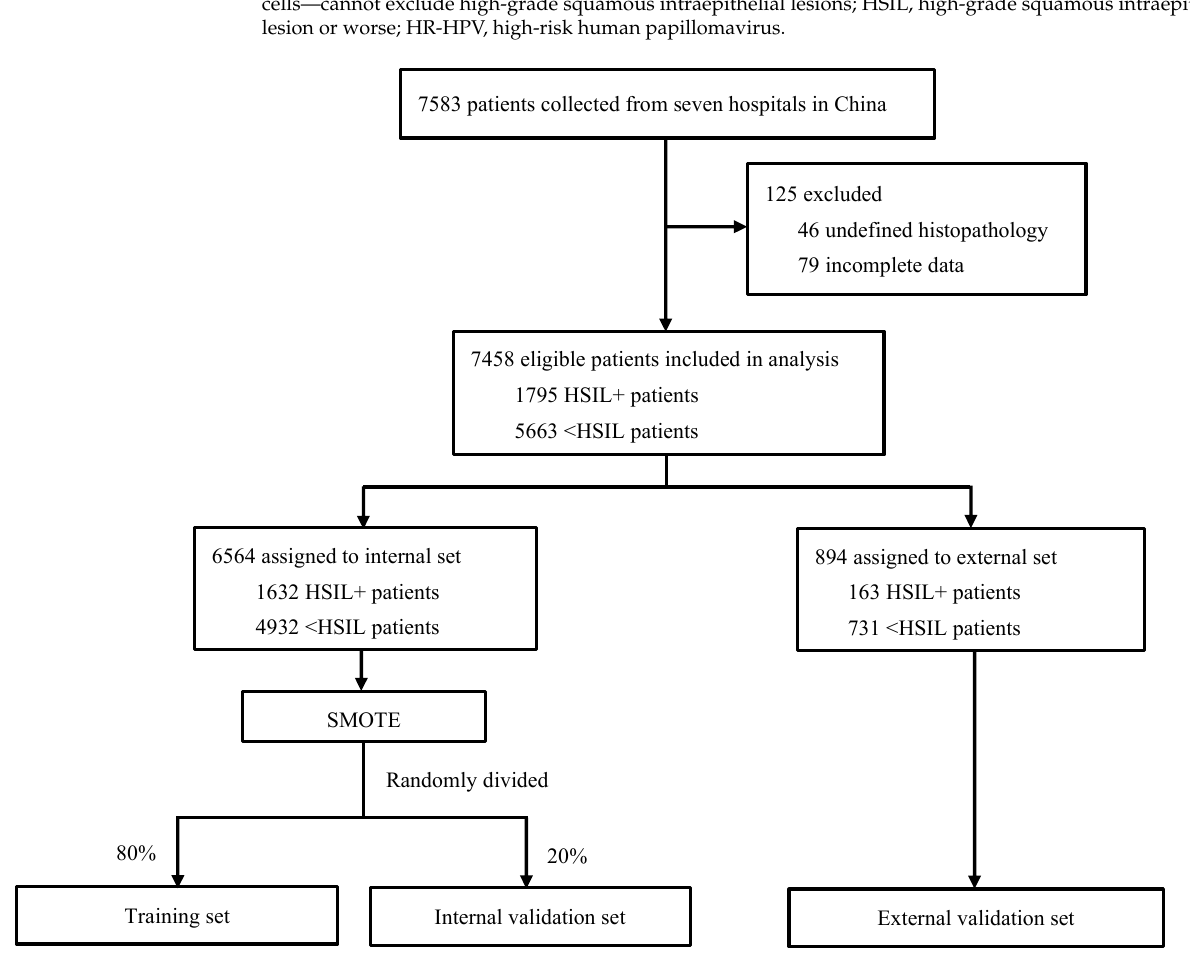
Figure 1. Flow chart showing the process of model development and validation. Abbreviations: <HSIL, normal or low-grade squamous intraepithelial lesion; HSIL+, high-grade squamous intraepithelial lesion or worse; SMOTE, synthetic minority oversampling technique. Table 1. Characteristics of the study population.